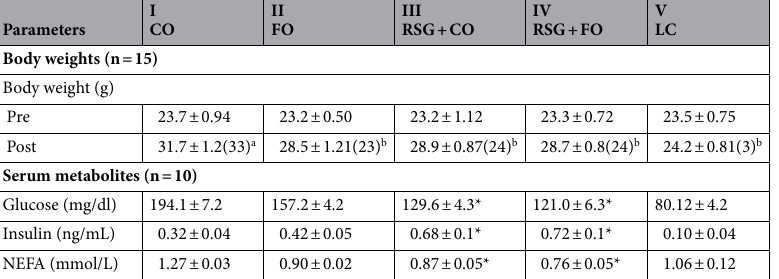
Table 1. Body weight and serum metabolites in C57Bl/6J aging mice after 5 months’ dietary supplementation with CO, FO and/or RSG, respectively, compared with LC controls. Values in parentheses are the differences between the pre- and post-supplementation values. Values with different letters, and sign indicate that values are significantly different by ANOVA, followed by Newman–Keuls multiple comparison post hoc test (p < 0.05). *p < 0.05 compared to CO-fed mice